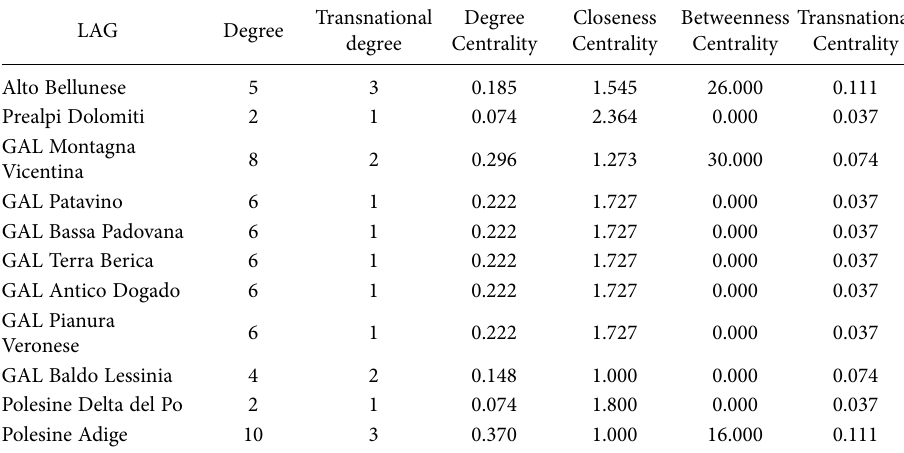
Table 10. Indexes of the transnational cooperation network of Veneto LAGs, by node, LEADER Axis.